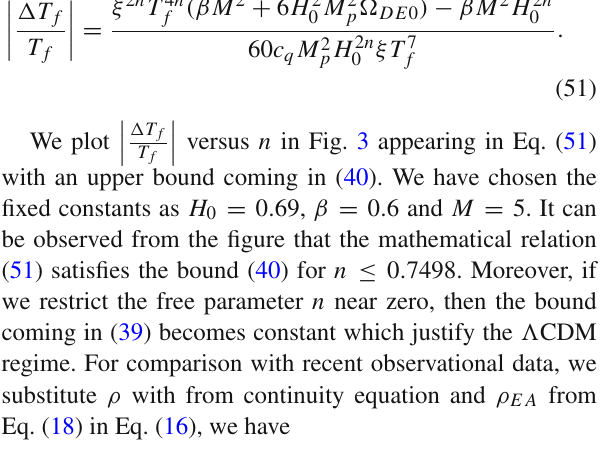
values of H 0 are as